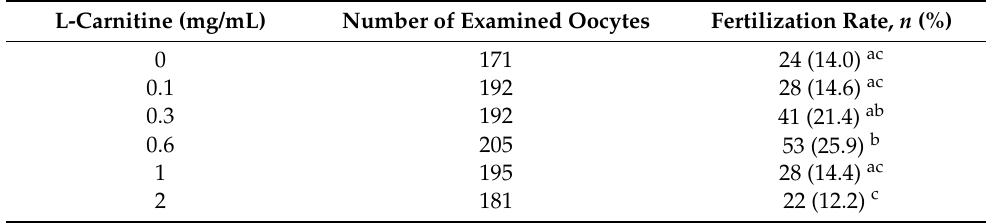
Table 2. Effects of L-Carnitine supplementation during IVM on fertilization rates of canine oocytes following in vitro fertilization (IVF) ( n =